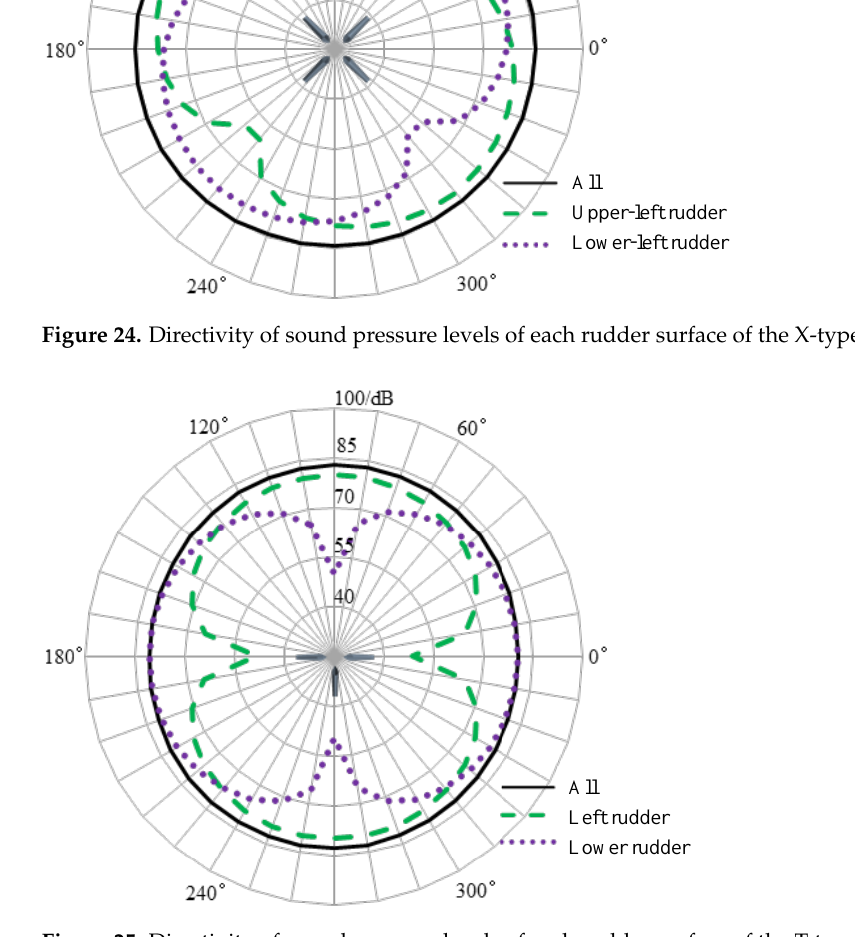
Figure 25. Directivity of sound pressure levels of each rudder surface of the T-type tail part.